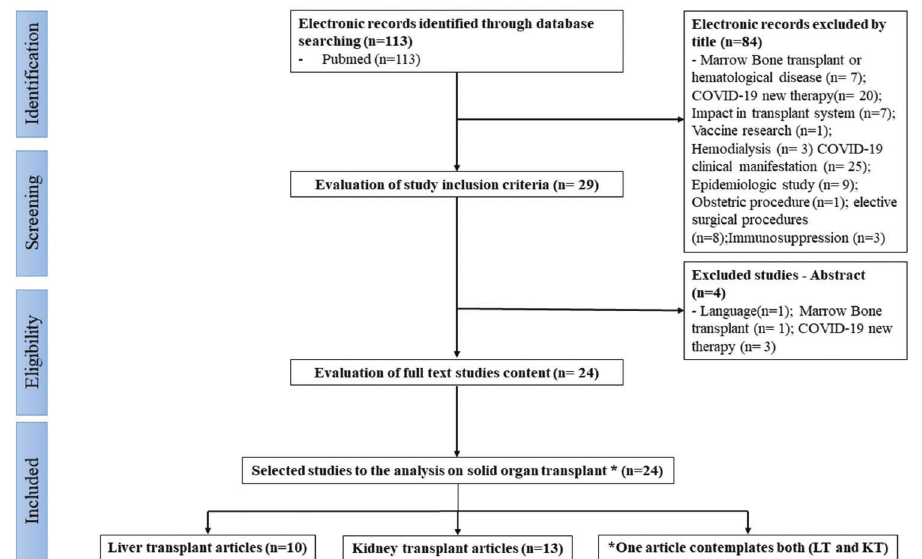
Figure 1 - Flow diagram of the systematic literature search according to the PRISMA statement. *Kidney transplant (KT) and liver transplant